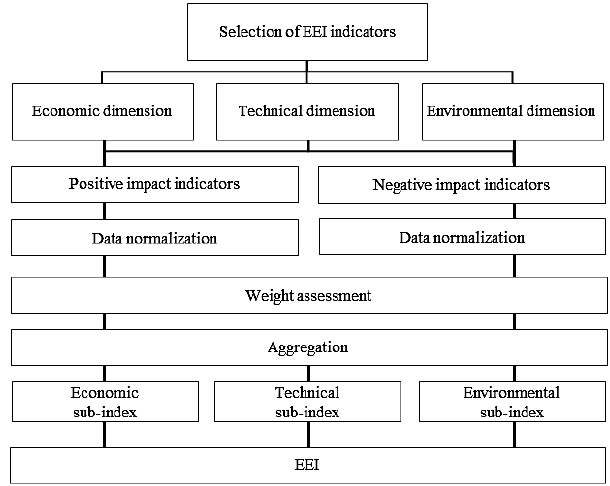
Fig. 1. Hierarchical procedure of the EEI calculation. Developed by the authors inspired by [3], [4], [6],